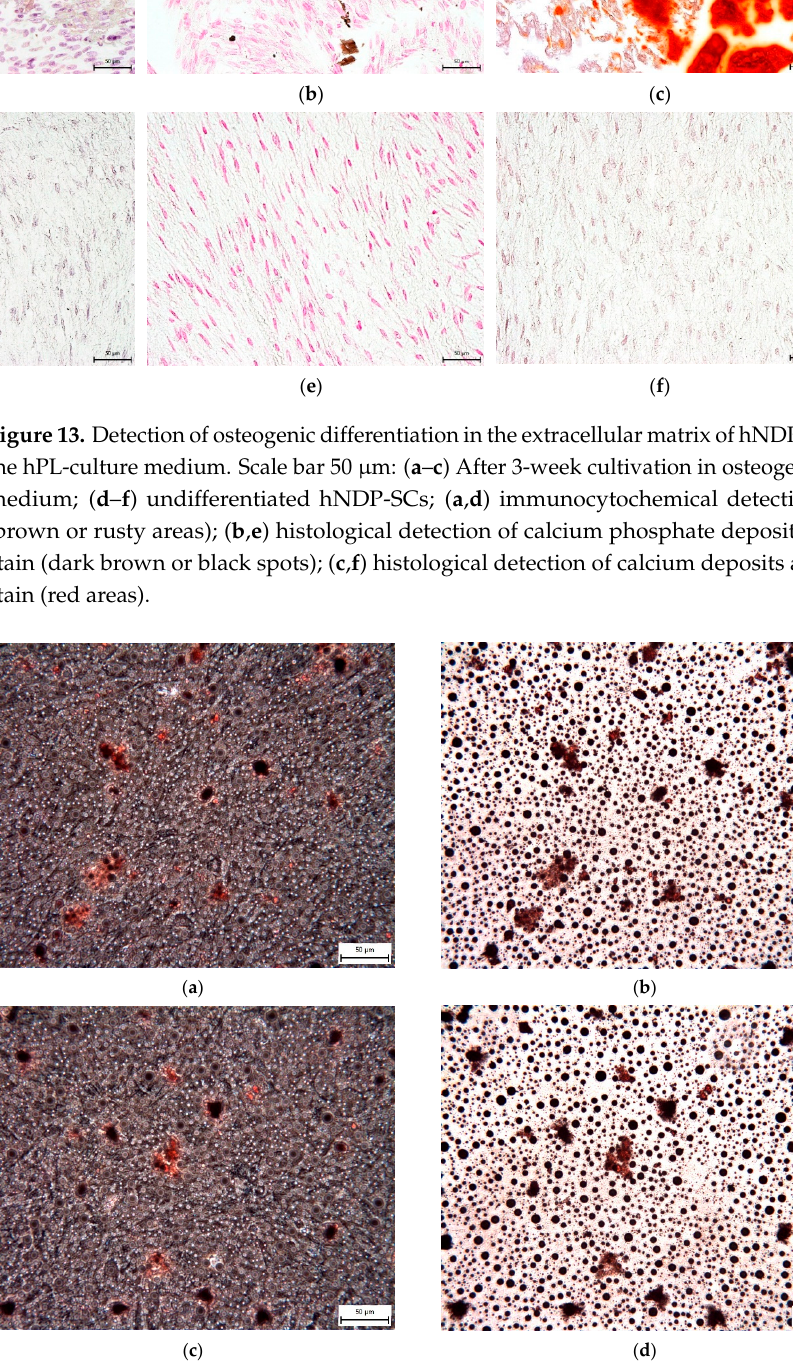
Figure 14. Detection of adipose droplets and vacuoles in the extracellular matrix of hNDP-SCs after 4-week cultivation in adipogenic differentiation medium. After red oil staining, the adipose vacuoles are revealed as red areas. Scale bar 50 μ m: ( a , b ) hNDP-SCs cultivated in the FBS-culture medium; ( c , d ) hNDP-SCs cultivated in the hPL-culture medium; ( a , c ) phase contrast optical microscope phase contrast microscope; ( b , d ) inverted optical microscope.